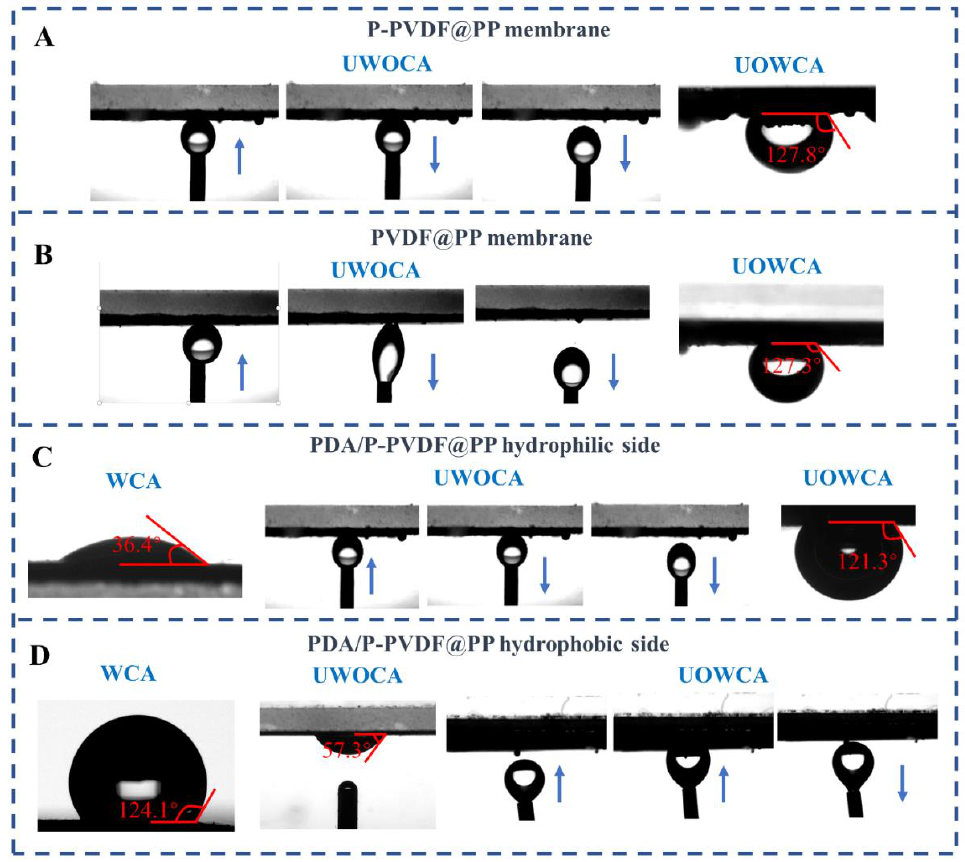
Figure 3. The UWOCA and UOWCA of ( A ) P − PVDF@PP membrane and ( B ) PVDF@PP membrane; the WCA, UWOCA, and UOWCA of ( C ) PDA/P − PVDF@PP hydrophilic side and ( D ) PDA/P − PVDF@PP hydrophobic side. All the arrows mean the direction of droplet motion.